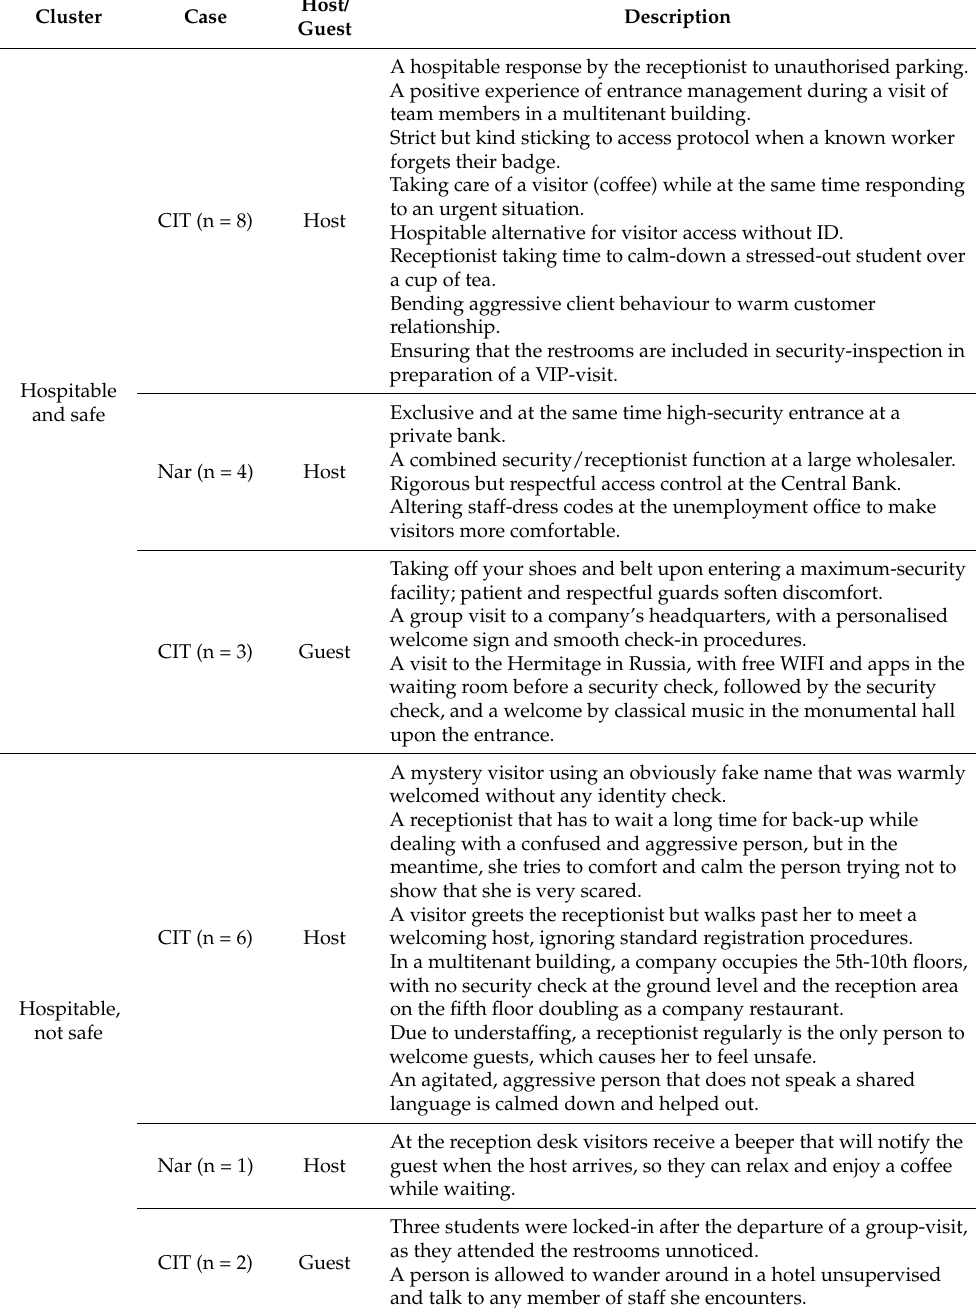
Table 3. Critical Incidents (CIT) and Narratives